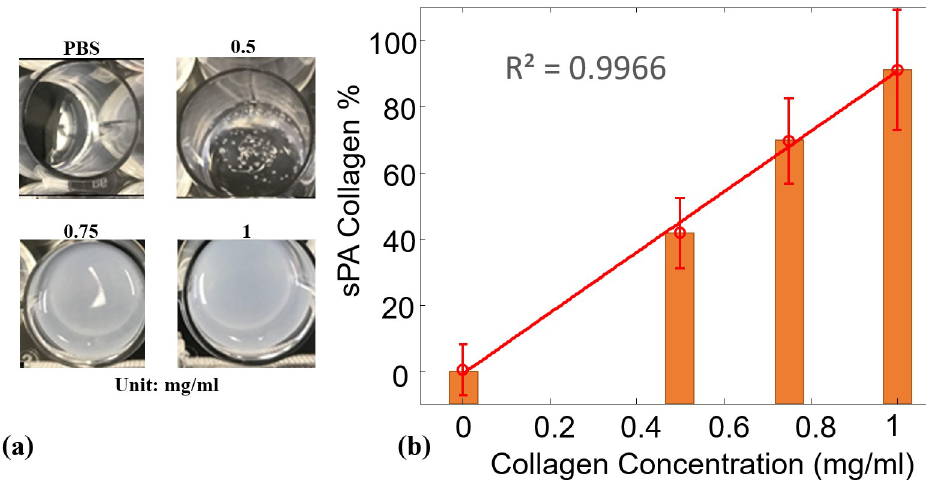
Fig 2. Collagen-to water-ratio in collagen phantoms. (a) Photograph of collagen phantoms at different concentrations ranging from 0 (PBS) to 1 mg/mL. (b) Normalized sPA-CWR to estimate the collagen concentration for the collagen phantoms at different concentrations. The linear curve fit showed a high correlation between the detected CWR to the collagen concentration, with the coefficient of determination (R2) of 99.66%.